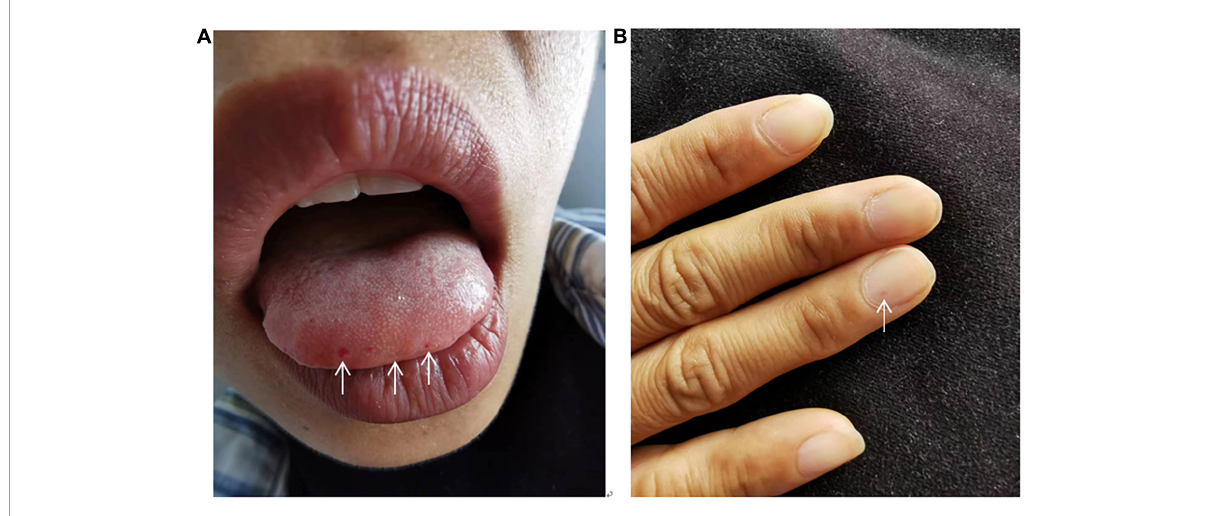
FIGURE1 Abnormal inspection. Cyanosis was noted on the lips, and telangiectasias were seen on the oral mucosa (A) and fingertips (B) .